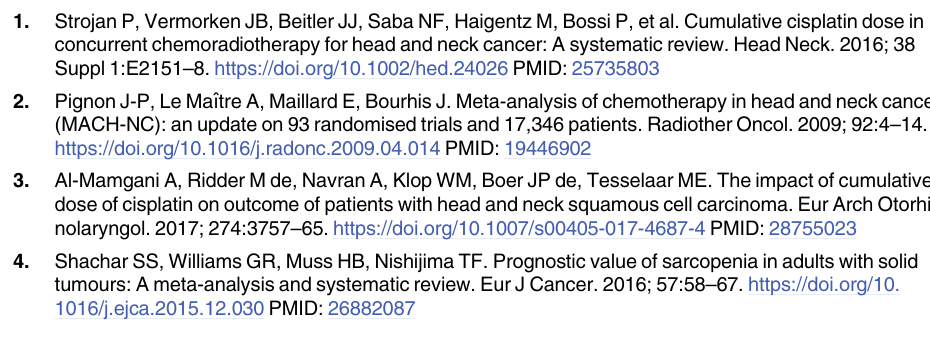
S1 Fig. Skeletal muscle measurements. Axial neck CT at the level of the third cervical vertebra with skeletal muscle measurements. (1) cross-sectional area (CSA) of the right sternocleido- mastoid muscle, (2) CSA of the left sternocleidomastoid muscle, and (3) CSA of the paraver- tebral muscles. a Patient with low skeletal muscle mass. b Patient without low skeletal muscle